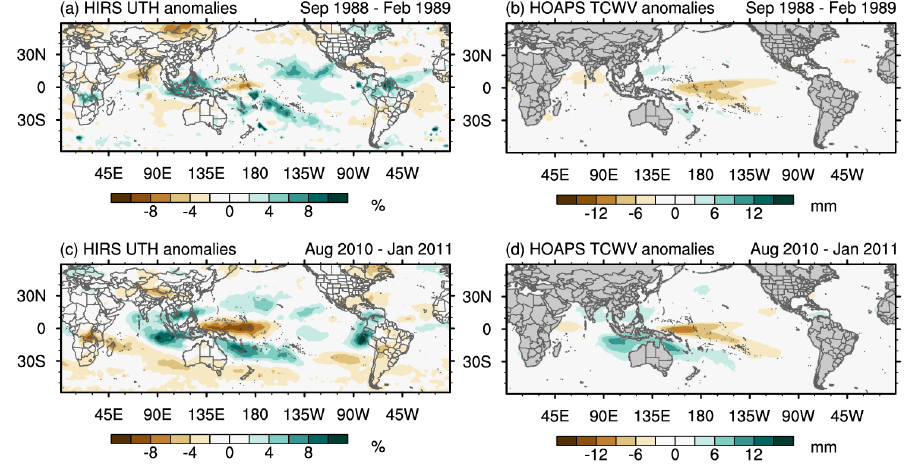
Figure 6. UTH (left panels) and TCWV (right panels) anomalies during the peak six months of the La Niña events for ( a – b ) 1988–89 and ( c – d ) 2010–11 events. Niña events for ( a – b ) 1988–89 and ( c – d ) 2010–11